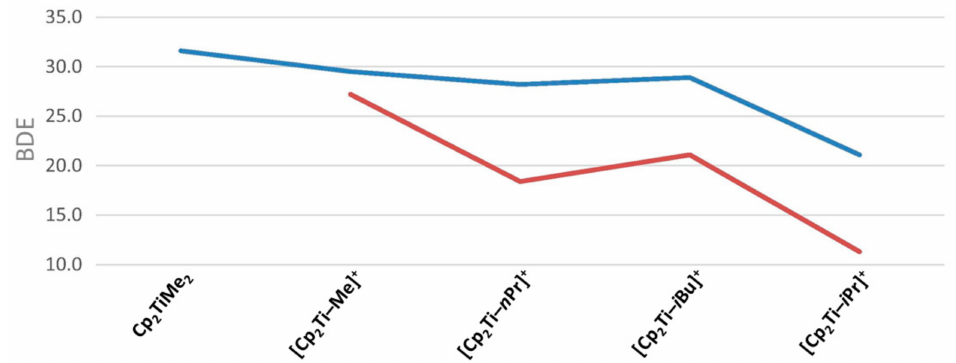
Figure 3. Density functional theory (DFT) calculated BDEs for Cp 2 TiMe 2 and [Cp 2 Ti–R] + naked (blue trace) and olefin stabilized (red trace) cations at 298 K. Adapted with permission from Reference